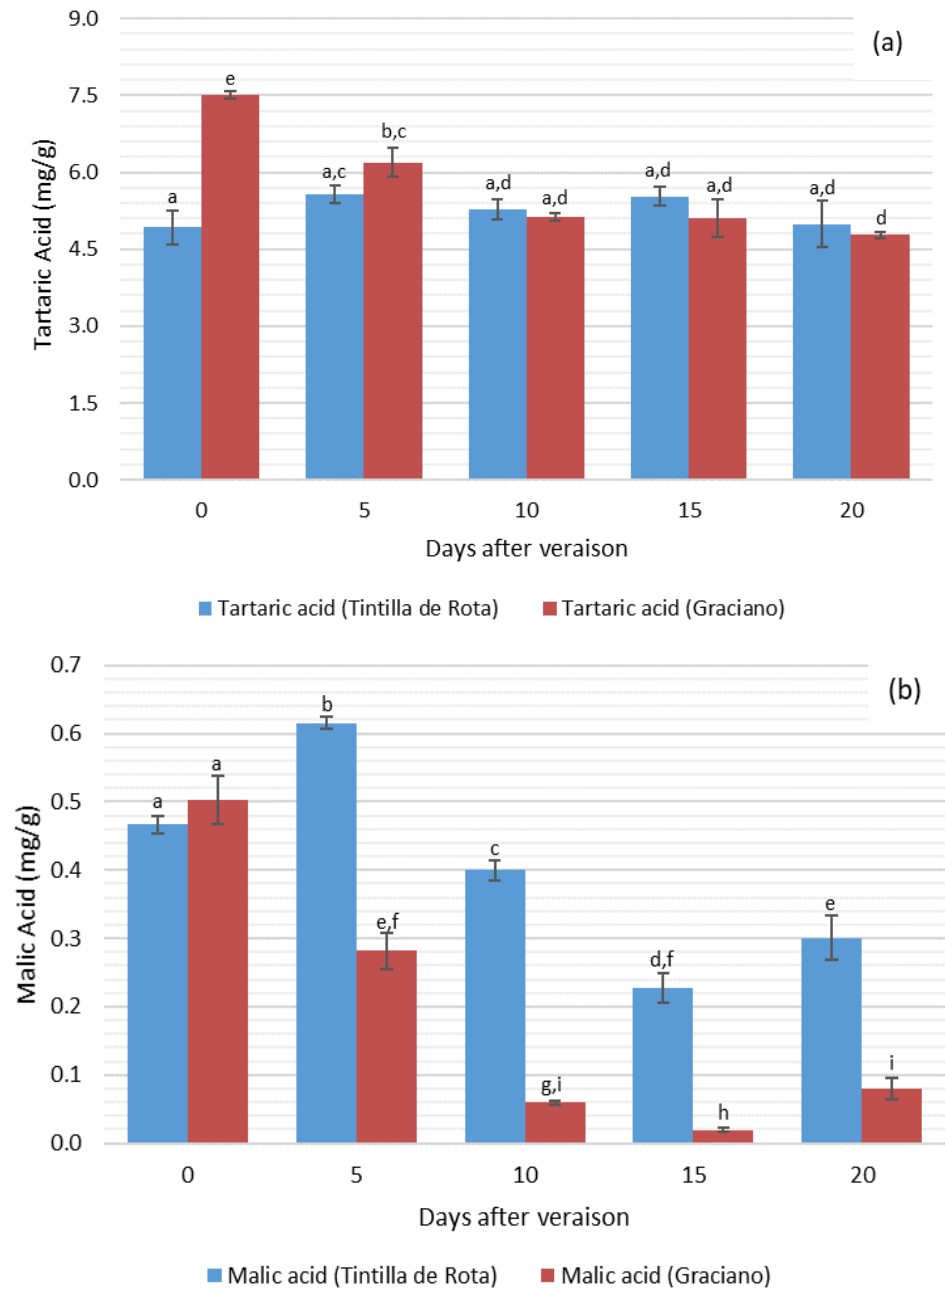
Figure 2. Variation of tartaric acid ( a ) and malic acid ( b ) concentration in ‘Tintilla de Rota’ and ‘Graciano’ accessions after ver á ison ( n = 3) in dry weight. Different letters mean there are significant differences between samples ( p < 0.05, two-way ANOVA, BSD test).